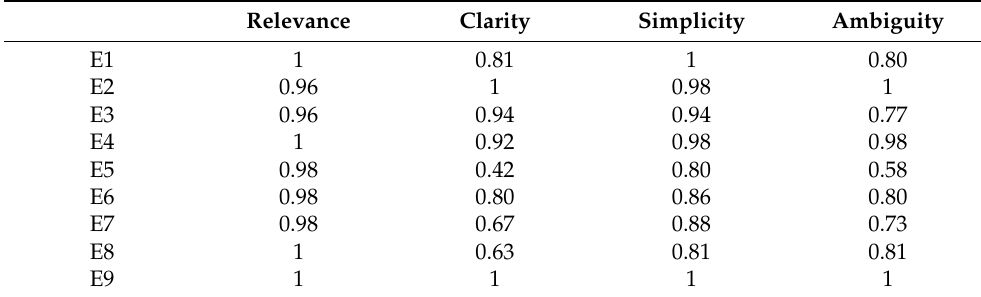
Table 2. Proportion of agreement among